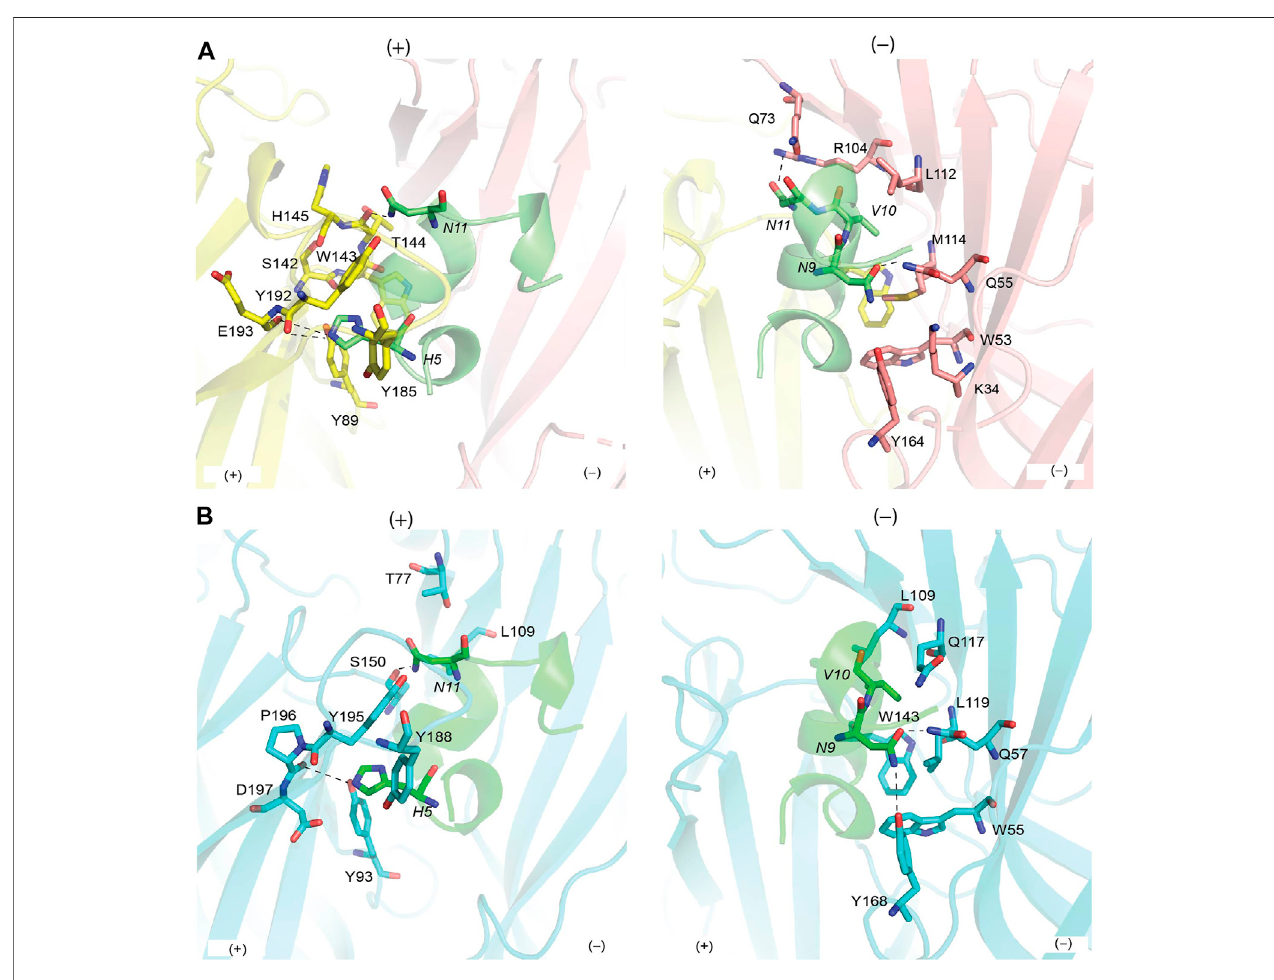
FIGURE 2 | Binding interface between OmIA with Ls-AChBP (A) and homology model of α 7 nAChRs (B) . (A) His5 resides in the pocket consisting of conserved aromatic side-chain residues on the principal side of the Ls -AChBP, while hydrogen bond (dash line) is seen between Asn11 and backbone oxygen of Thr144. On the complementary side, Asn9 and Val10 show extensive contacts with the complementary side, with hydrogen bonds between Asn9/Gln55 and Asn9/Tyr164. ( B ) The binding surface of OmIA at α 7 nAChRs is comparable to Ls -AChBP. Hydrogen bonds between Asn9/Gln57 (equivalent to Ls -AChBP_Gln55), Asn9/Tyr167 (equivalent to Ls -AChBP_Tyr164), Asn11/backbone Ser14450 (equivalent to Ls -AChBP_Thr144) remain intact in the α 7 subtype. Residues of OmIA are in